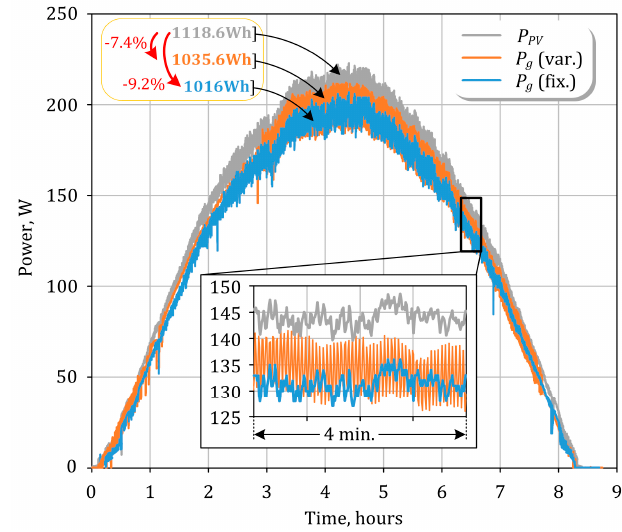
Figure 7. Experimental daily energy production for two dc-link voltage controls (var.: variable dc-link voltage control; fix.: fixed dc-link voltage control).